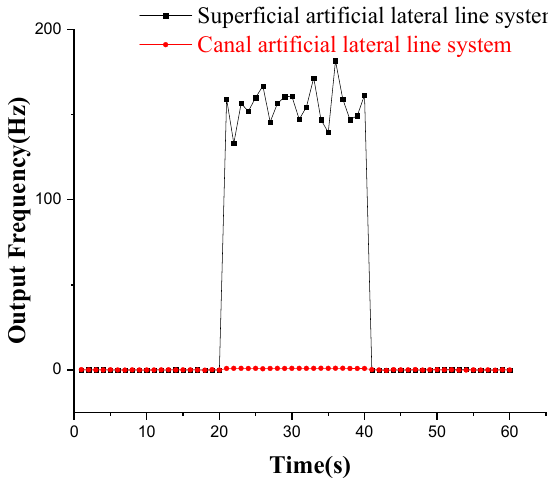
Figure 16. Comparison curve of output signals of two sensors at 5 m/s air flow velocity.